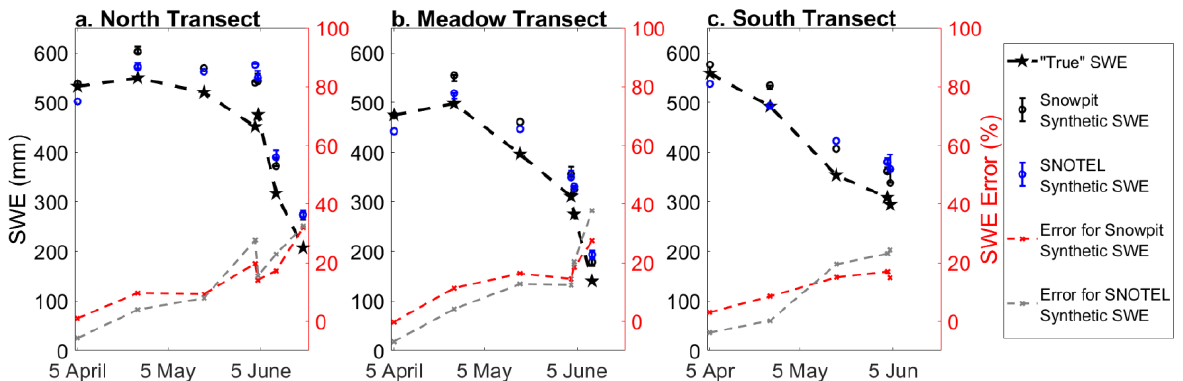
Figure 14. SWE calculations from probe and snowpit datasets (“True” SWE) compared to synthetic SWE retrievals based on a 0 vol. % LWC assumption for snowpit densities and SNOTEL densities. Percent error shown in red represents the synthetic SWE retrievals using the local snowpit density. Percent error shown in gray represents the synthetic SWE retrievals using the Joe Wright SNOTEL station density. Percent error given as the mean percent error from the